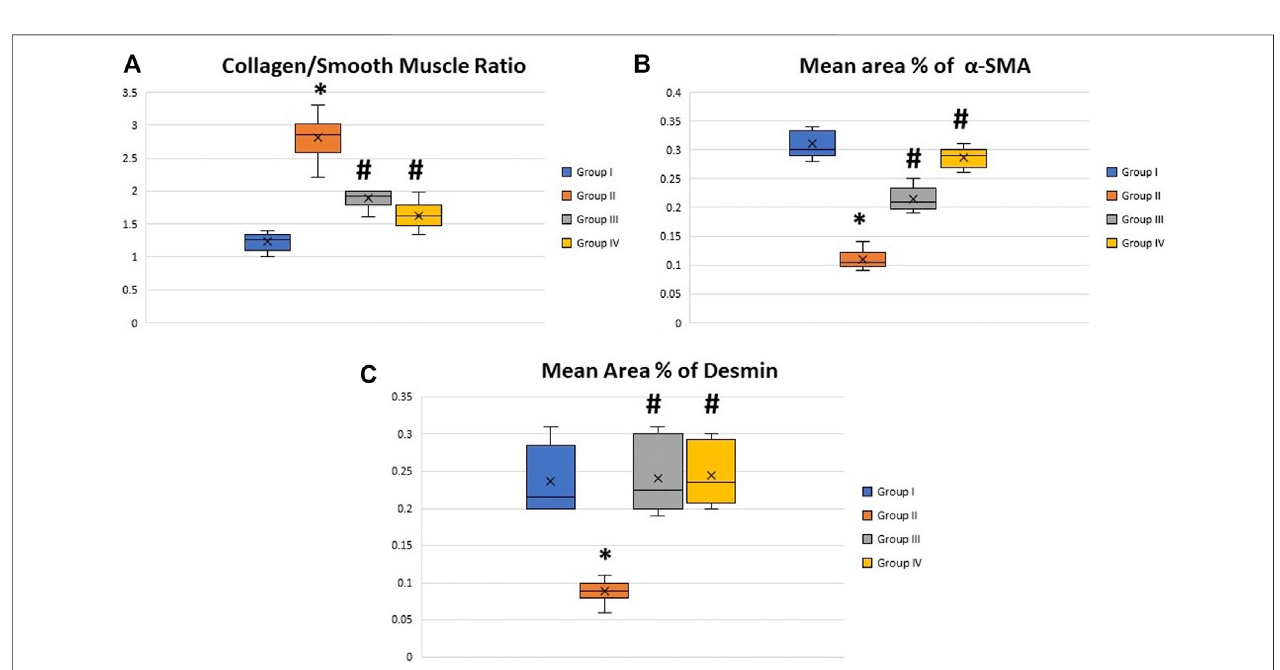
FIGURE7| Boxplotchartsshowingthecollagen/smoothmuscleratio (A) ,themeanareapercentageof α -SMA (B) ,andthemeanareapercentageofdesmin (C) in thecorporacavernosaofallratsinallgroups.Theexpressionof α -SMAanddesminsigni fi cantlydecreasedinthediabeticrats(groupII),whilethecollage/smoothmuscle ratio signi fi cantly increased in the same group. Both treated groups (groups III and IV) showed almost restoration of the control values. *Signi fi cant difference compared to group I ( p < 0.05). #Signi fi cant difference compared to group II ( p < 0.05).